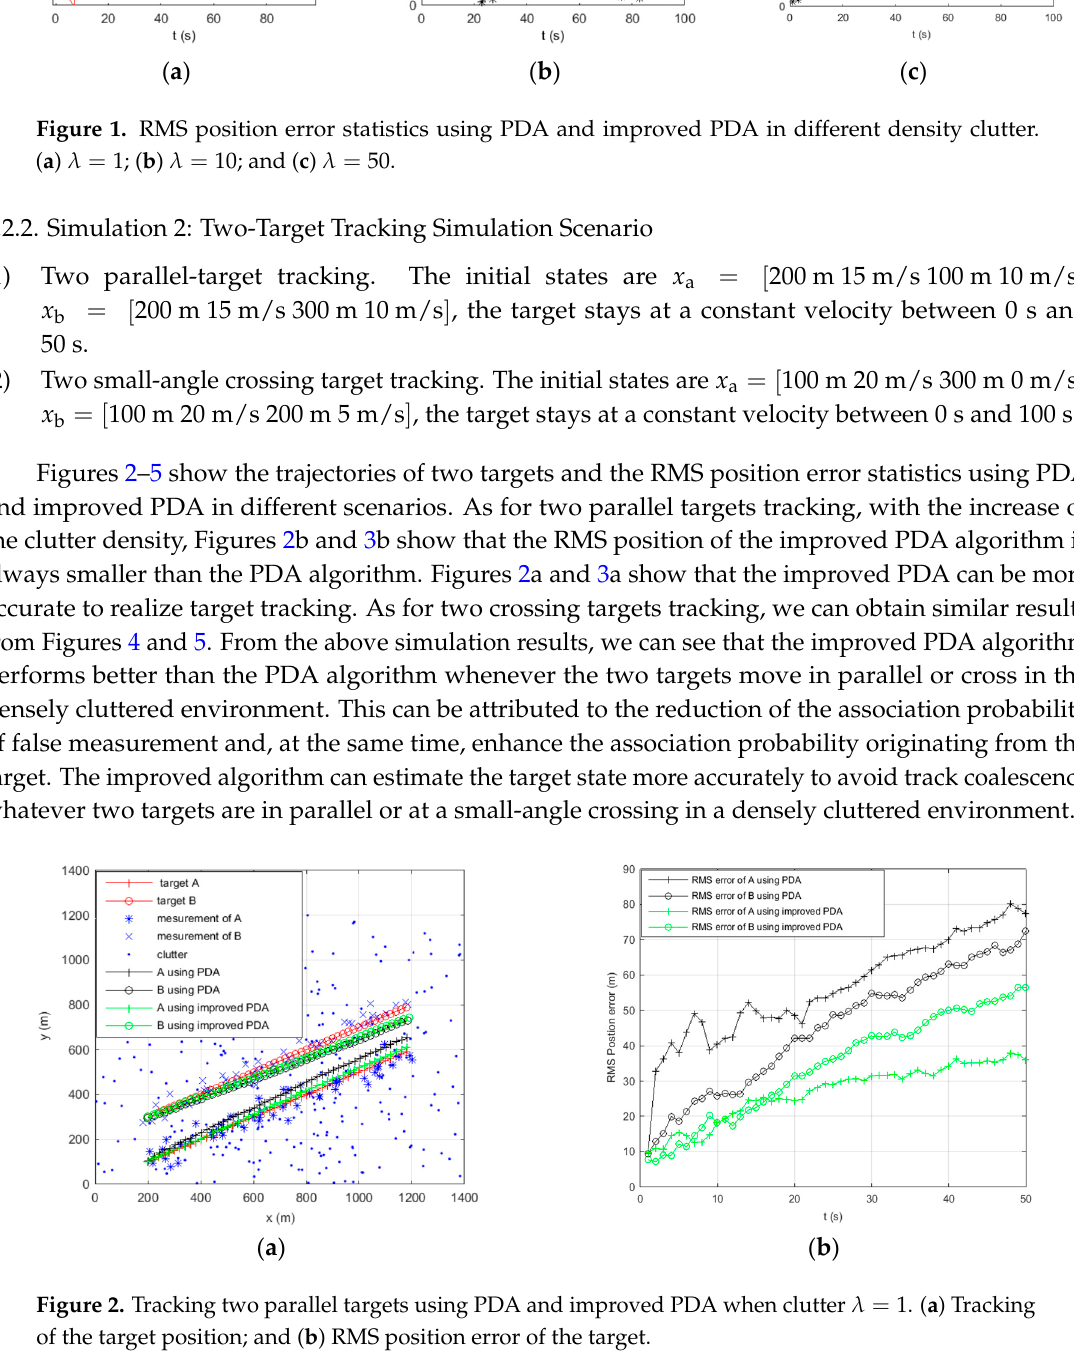
( b ) Figure 3. Tracking two parallel targets using PDA and improved PDA when clutter 5 . ( a ) Tracking of the target position; and ( b ) RMS position error of the target. ( a ) ( b ) Figure 4. Tracking two crossing targets using PDA and improved PDA when clutter 1 . ( a ) Tracking of the target position; and ( b ) RMS position error of the target.